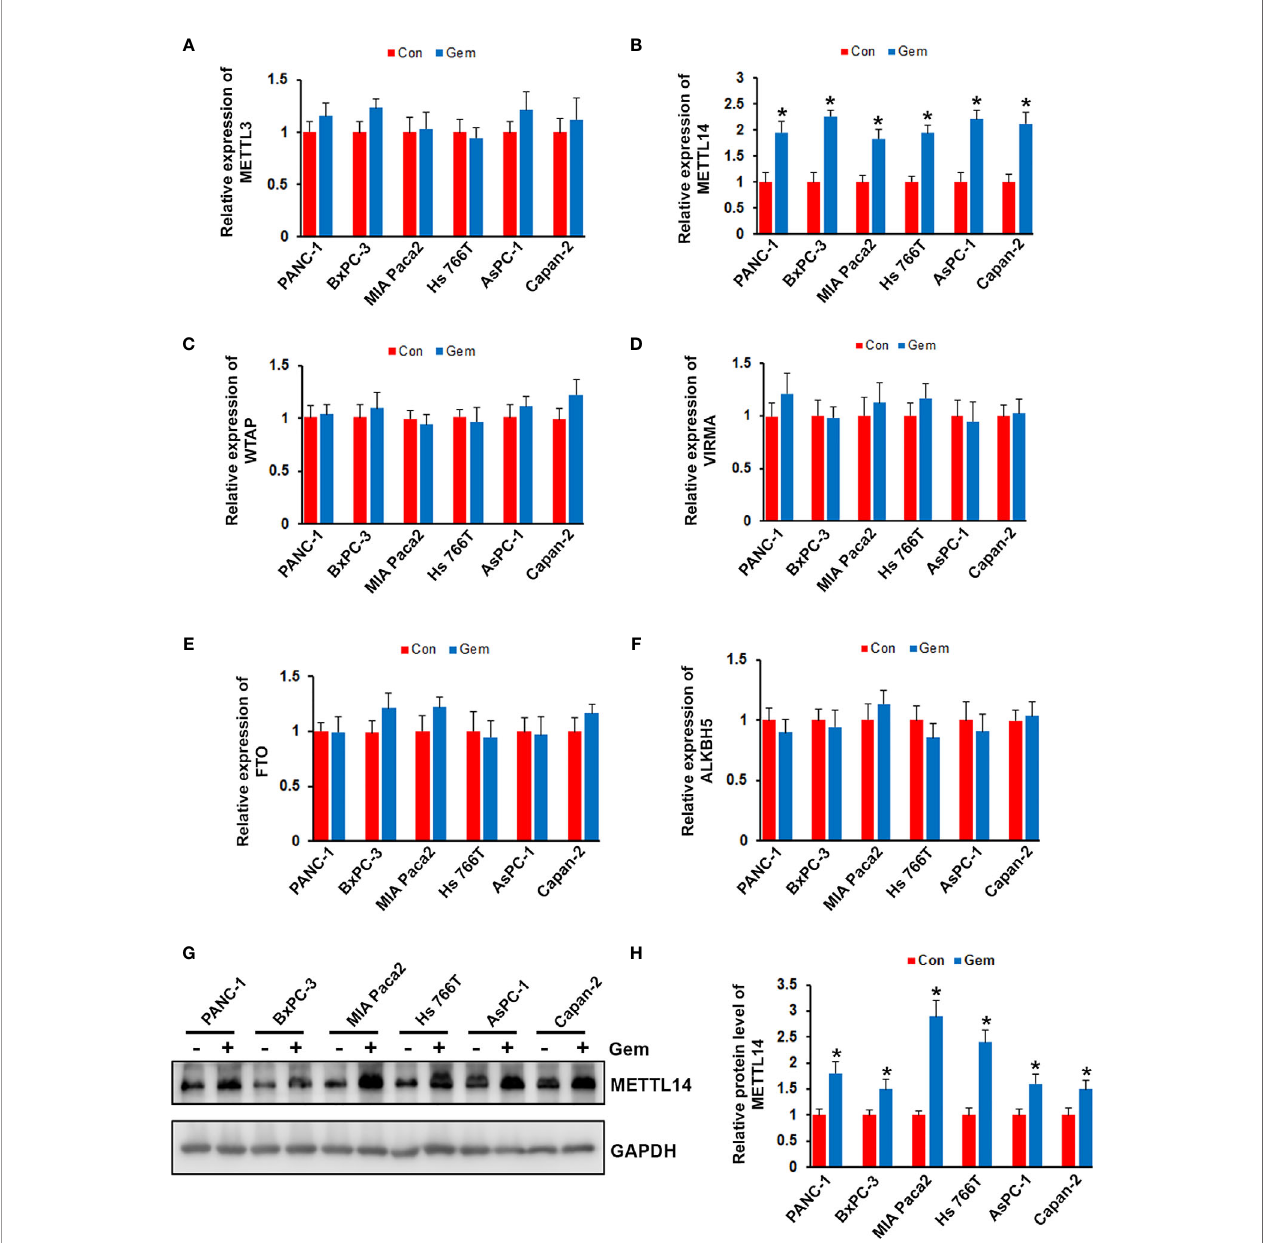
FIGURE 1 | Effect of gemcitabine on METTL14 expression. (A – F) Pancreatic cancer cells (PANC-1, BxPC-3, MIA Paca2, Hs 766T, AsPC-1 and Capan-2) were treated with 100nM gemcitabine for 48 hours, the mRNA level of METTL3, METTL14, WTAP, VIRMA, FTO, and ALKBH5 was assessed by QRT-PCR. *p < 0.05. (G) Pancreatic cancer cells were treated with 100nM gemcitabine for 48 hours, the protein level of METTL14 was assessed by western blotting. (H) Quanti fi cation of METTL14 protein levels in pancreatic cancer cells treated with or without gemcitabine. Data are reported as means ± SEM of values from three experiments. *p <